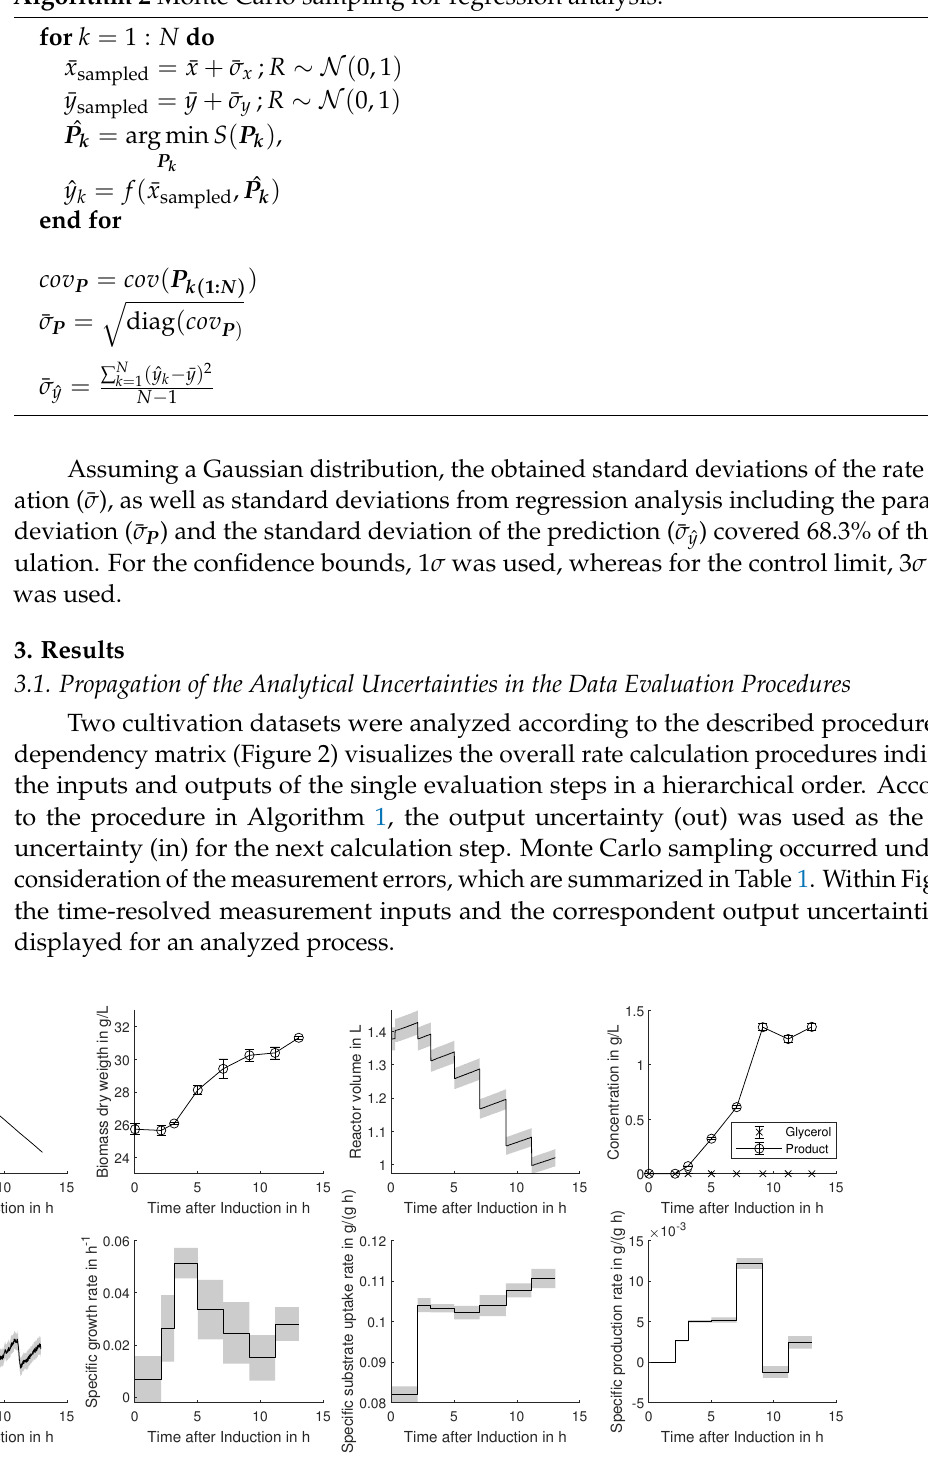
Figure 1. Time-resolved input and rate calculation output data for an exemplary cultivation ( E. coli ). The rate calculation results are displayed as the black line, and the associated uncertainty, obtained by Monte Carlo resampling, is displayed as grey